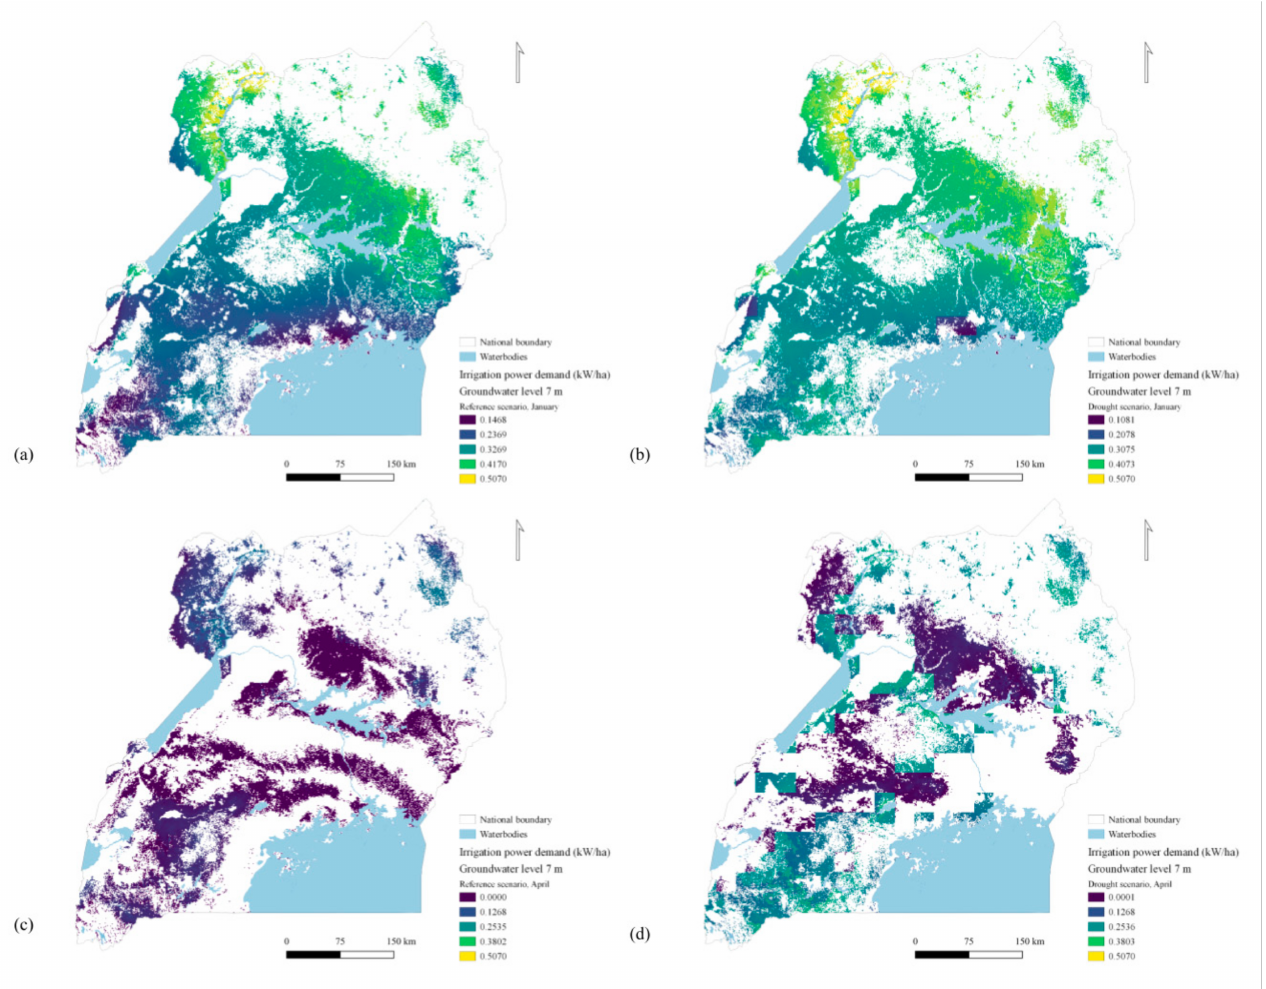
Figure 13. Peak power demand for irrigation water pumping (kWh/ha) compared between the reference and drought scenario in the normally wettest and driest months (January and April), respectively. The results are presented as follows: ( a ) January, reference scenario, ( b ) January, drought scenario, ( c ) April, reference scenario, and ( d ) April, drought